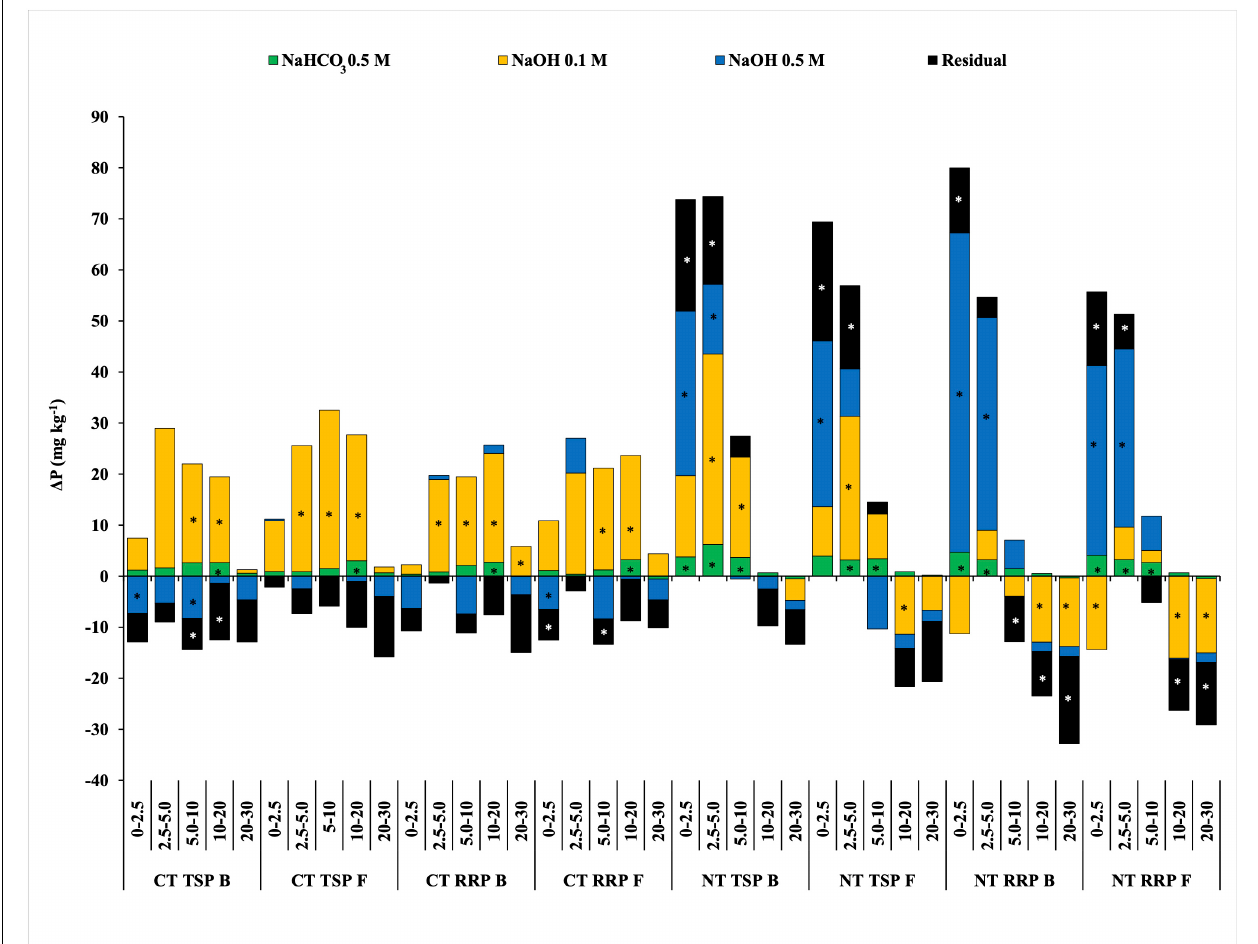
FIGURE 4 | Variation in the Po pool in relation to natural Cerrado in five layers of a very clayey Oxisol after 17 years of cultivation under distinct soil management systems and phosphate fertilizer sources and application methods. CT, conventional tillage; NT, no-tillage; TSP, triple superphosphate; RRP, reactive rock phosphate; B, broadcast; F, furrow. *Significant according to the Student’s t-test at P < 0.05.